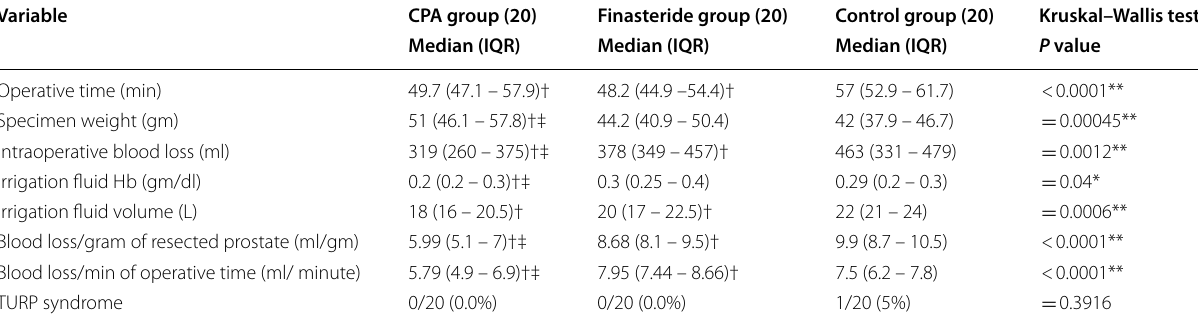
Table 2 Comparison between the 3 groups as regards intraoperative data using Kruskal–Wallis test and Significant KW test was followed by post hoc multiple comparisons using Bonferroni test to detect the significant pairs